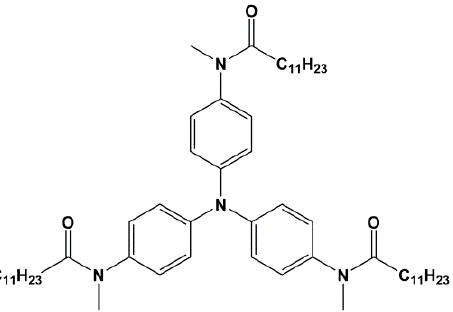
Figure A1. ( a ) OPVR; ( b ) OPVOH. For synthesis see reference [4].